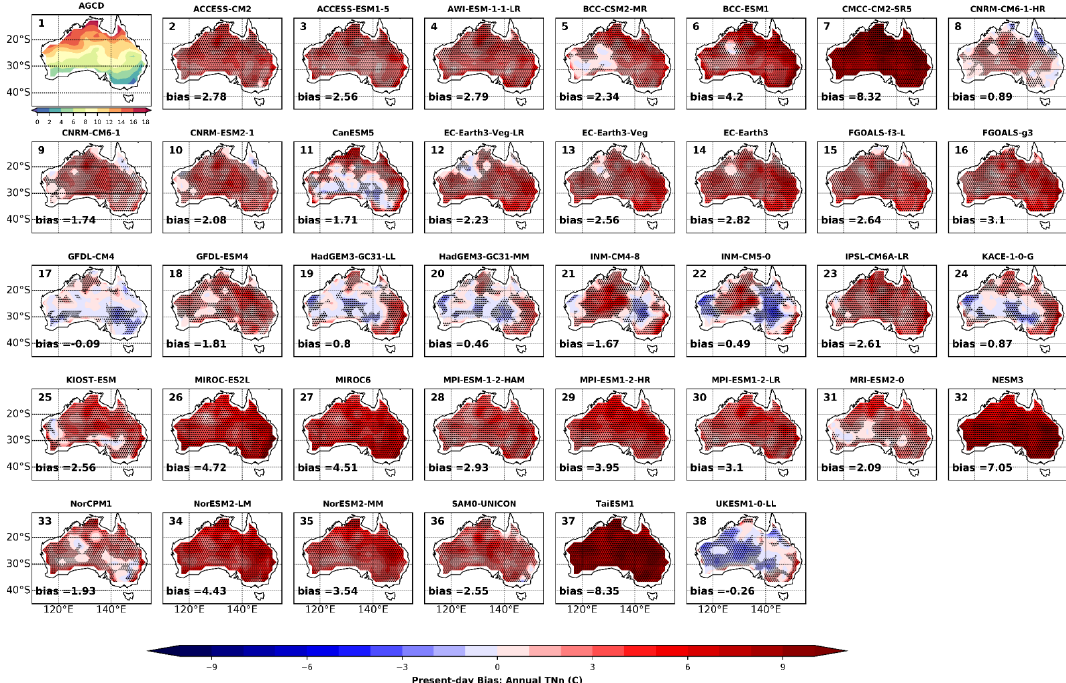
Figure 9. Climatological mean annual bias in the minimum minimum temperature (TNn: °C) relative to the Australian Gridded Climate Data dataset (AGCD; panel 1 ) for the individual CMIP6 GCMs (panels 2 – 38 ). Data spans 1951–2014. Stippling indicates statistically significant differences using a student’s t-test at the 95% confidence level.